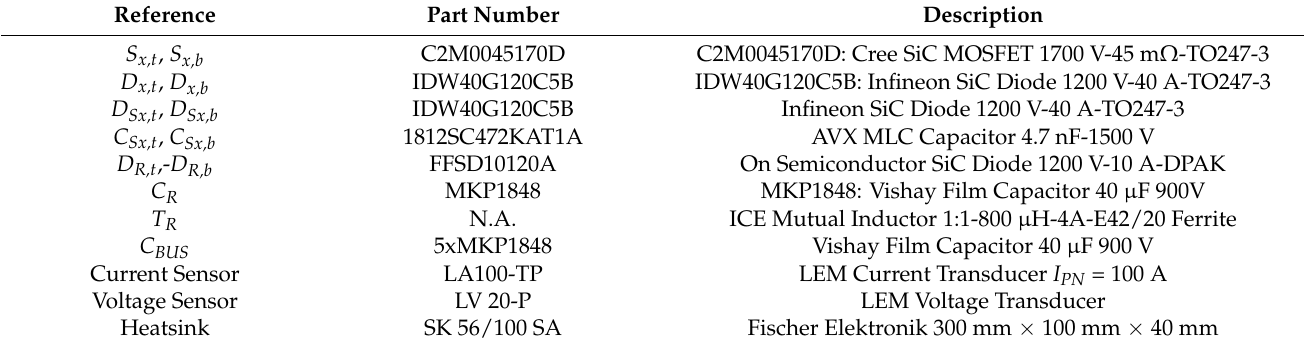
Table 2. Component description used to build the three-phase S2L prototype.